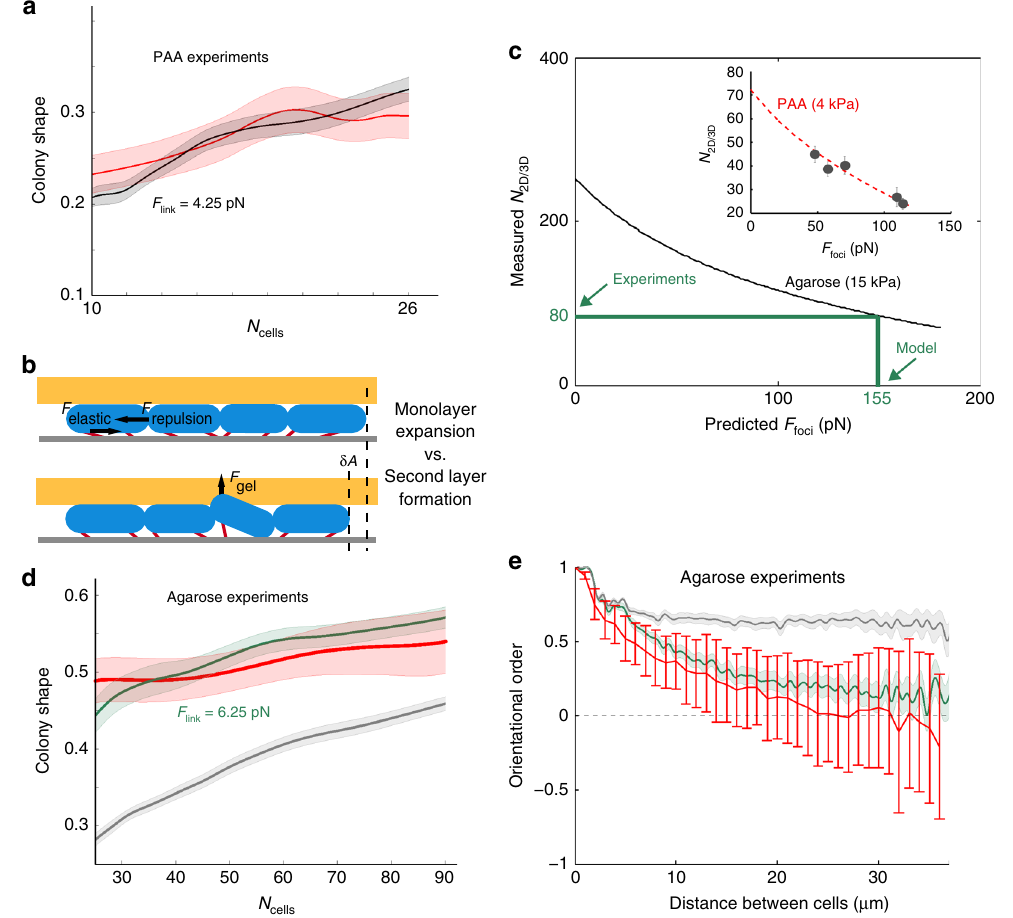
Fig. 4 Simulation of microcolony morphogenesis and force prediction. a Measured aspect ratio of WT E. coli microcolonies grown in force microscopy experiments (red, N = 26) compared to simulations (black: N = 10, F link = 4.25 pN). b When the microcolony expands in the plane (upper panel), both the elastic energy of the links ( E adh ) and the repulsive energy of steric interactions ( E rep ) increase. In contrast, when a bacterium goes into 3D and initiates second layer formation, it releases its repulsive energy and the microcolony saves a small area δ A in surface expansion . Yet, the bacterium must pay a cost in order to deform the gel and to extend its elastic links in the vertical direction. c Scaling between the size of the microcolony at second layer formation ( N 2D/3D ) and the force in adhesion foci ( F foci ) for an agarose gel (15 kPa, black line). Thanks to the relation between N 2D/3D and F foci (see Eq. (20) in Methods), we inferred the force at adhesion foci F foci in glass – agarose experiments from the number of bacteria at the onset of the second layer (Fig. 1e). In the inset, comparison between the theory for a soft PAA gel (4 kPa, red dashed line) and experimental values reported in Fig. 3d (dark gray dots). d Comparison of colony shape between experimental data of WT E. coli microcolonies (red) in glass – agarose experiments (Fig. 1a) and simulations (polar, green; uniform, gray). e Comparison of the orientational order in microcolonies between experimental data on WT E.coli (red) and simulation (polar, green; uniform, gray). In d and e , the simulations are de fi ned as polar when adhesive links form only at poles, and uniform when they form homogeneously